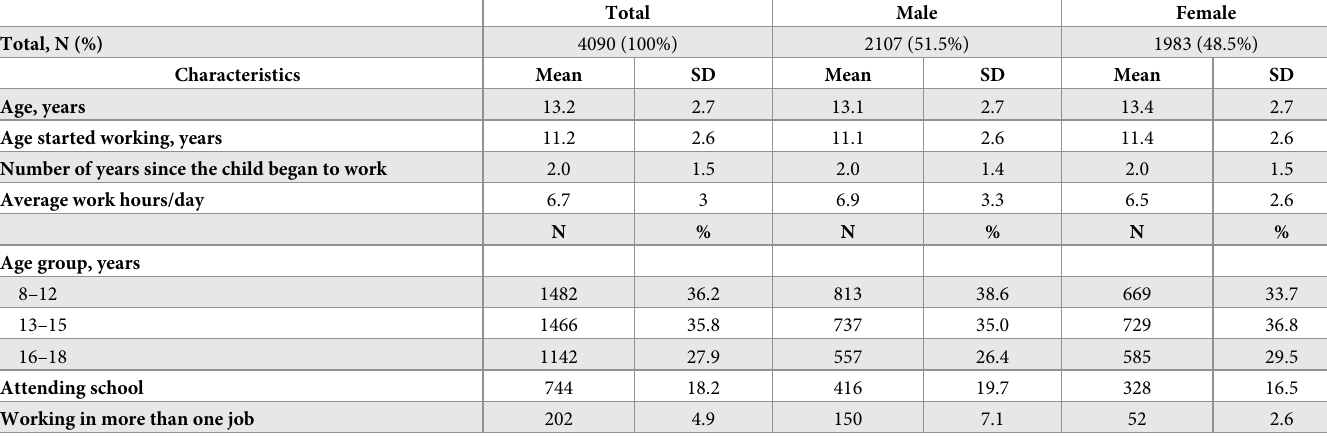
Table 1. Sociodemographic and work characteristics of Syrian refugee working children (8–18 years) in the Bekaa Valley, Lebanon, 2017 (N = 4090).